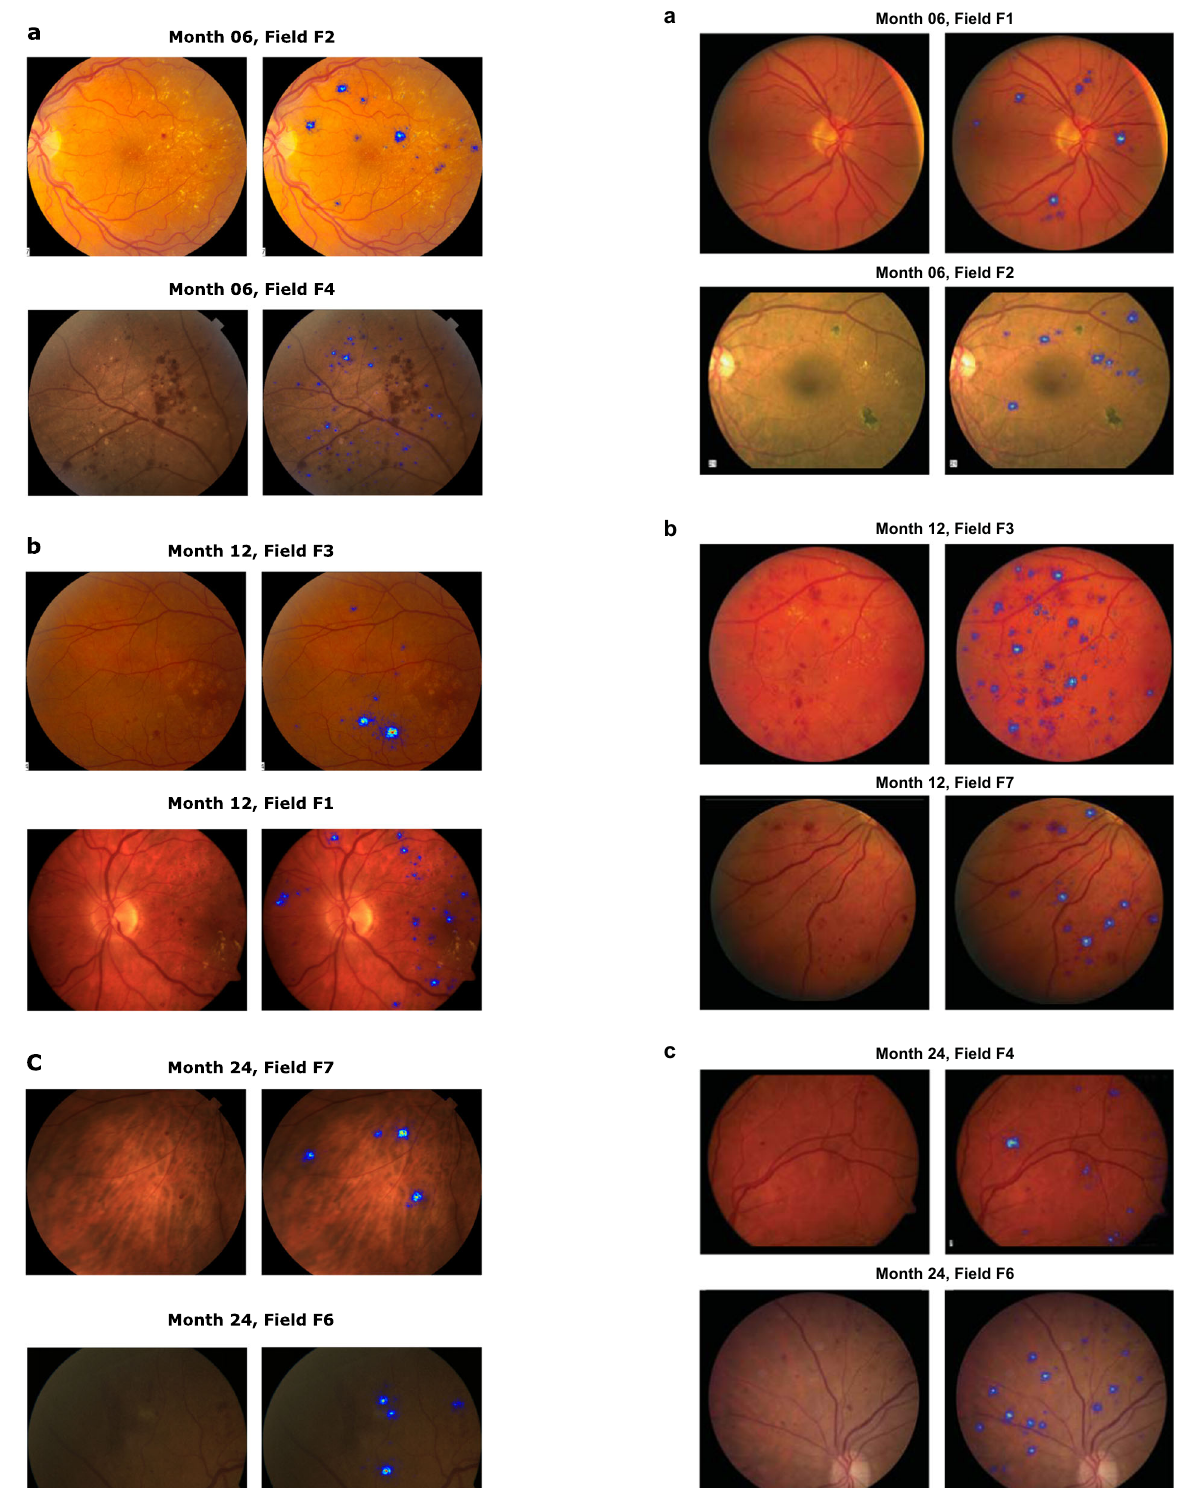
The incorrect version of Fig. 4 appears